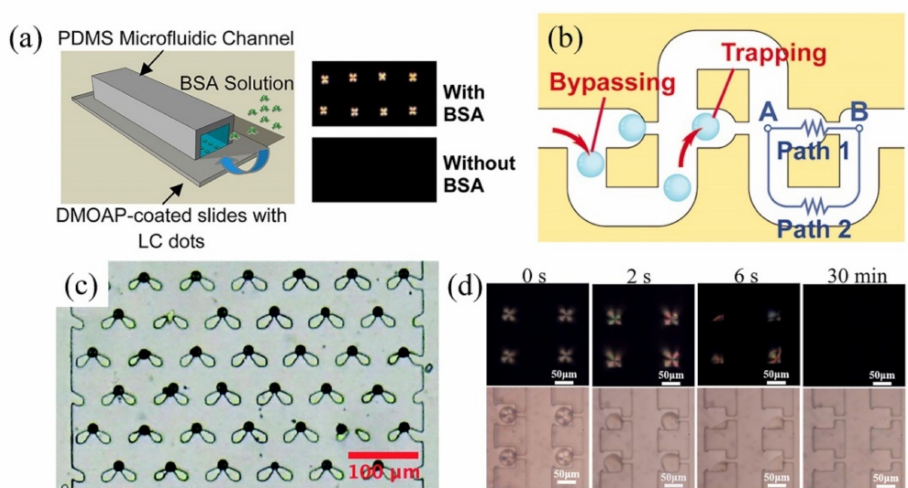
Figure 7. ( a ) LC droplet-based static microarray for the detection of BSA. Reprinted with permission from ref. [54]. Copyright 2013 American Chemical Society. ( b ) The schematic diagram of the trap mechanism using by-pass microfluidic channel. Reprinted with permission from ref. [100]. Copyright 2007 National Academy of Science of the USA. ( c ) Optical microscopy image of LC droplets trapped in a swallowtail shaped microstructure. Reprinted with permission from ref. [57]. Copyright 2019 Royal Society of Chemistry. ( d ) Polarizing optical microscopy and corresponding bright-field microscopy images of LC droplet-based microarray after the introduction of 20 µ M cholic acid at a constant flow rate of 3 µ L/h. Reprinted with permission from Reference [55]. Copyright 2020